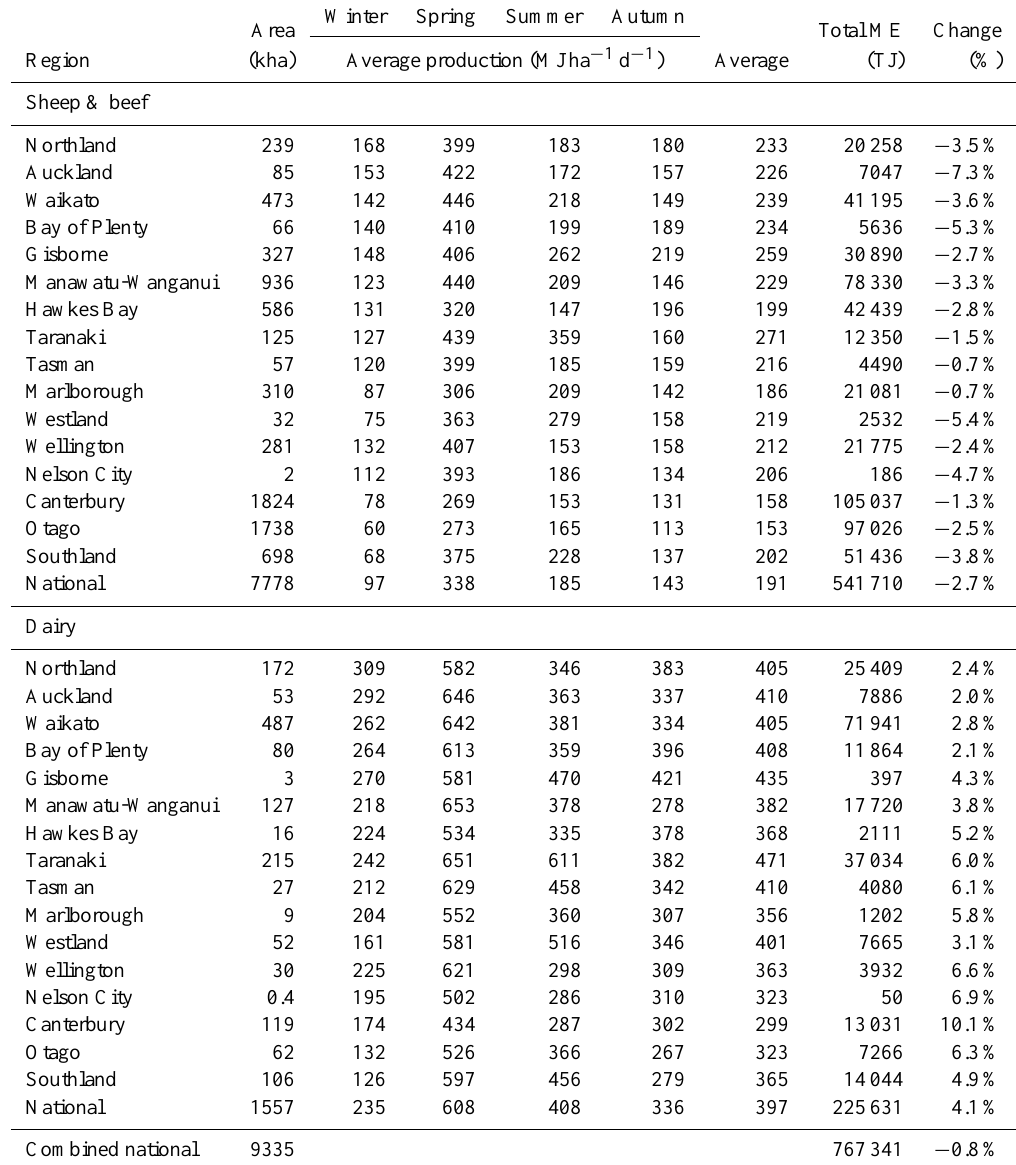
Table B8. Climate change 2100 (MPI